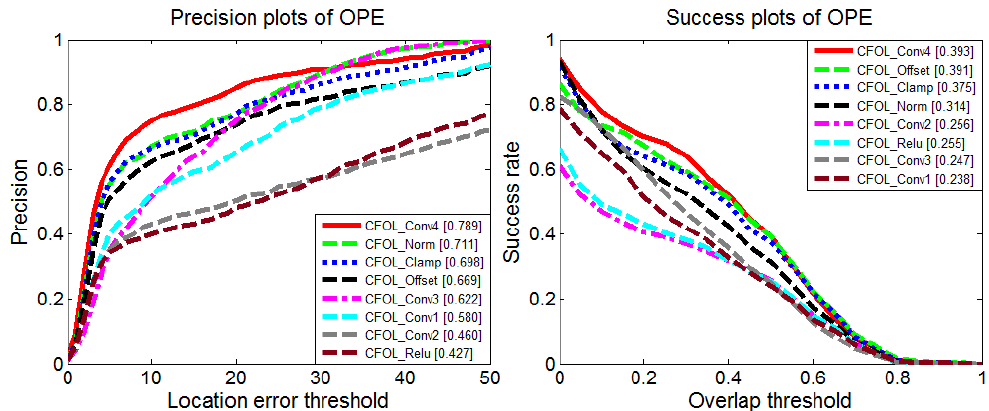
Figure 7. Performance comparison using features from different layers. OPE, One-Pass Evaluation. CFOL: Convolutional Features with Online Learning.